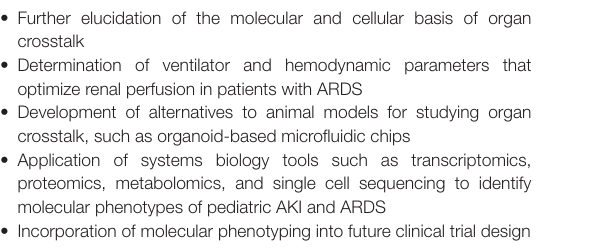
TABLE 3 | Future basic and translational research directions in kidney-lung